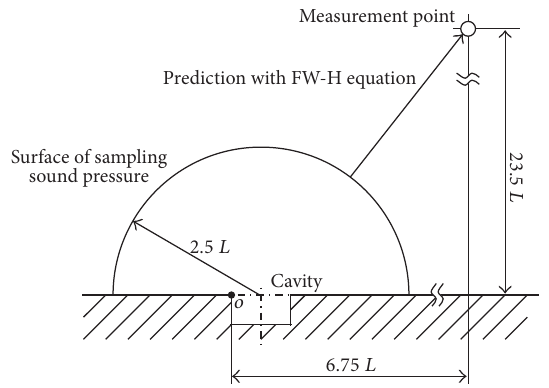
Figure 6: Schematics for prediction of acoustic far field by porous